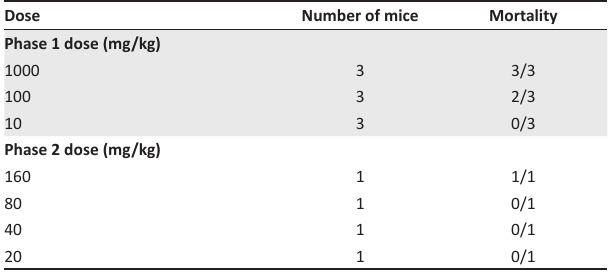
FIGURE 2: Effect of betulinic acid on acetic acid-induced writhing in mice.